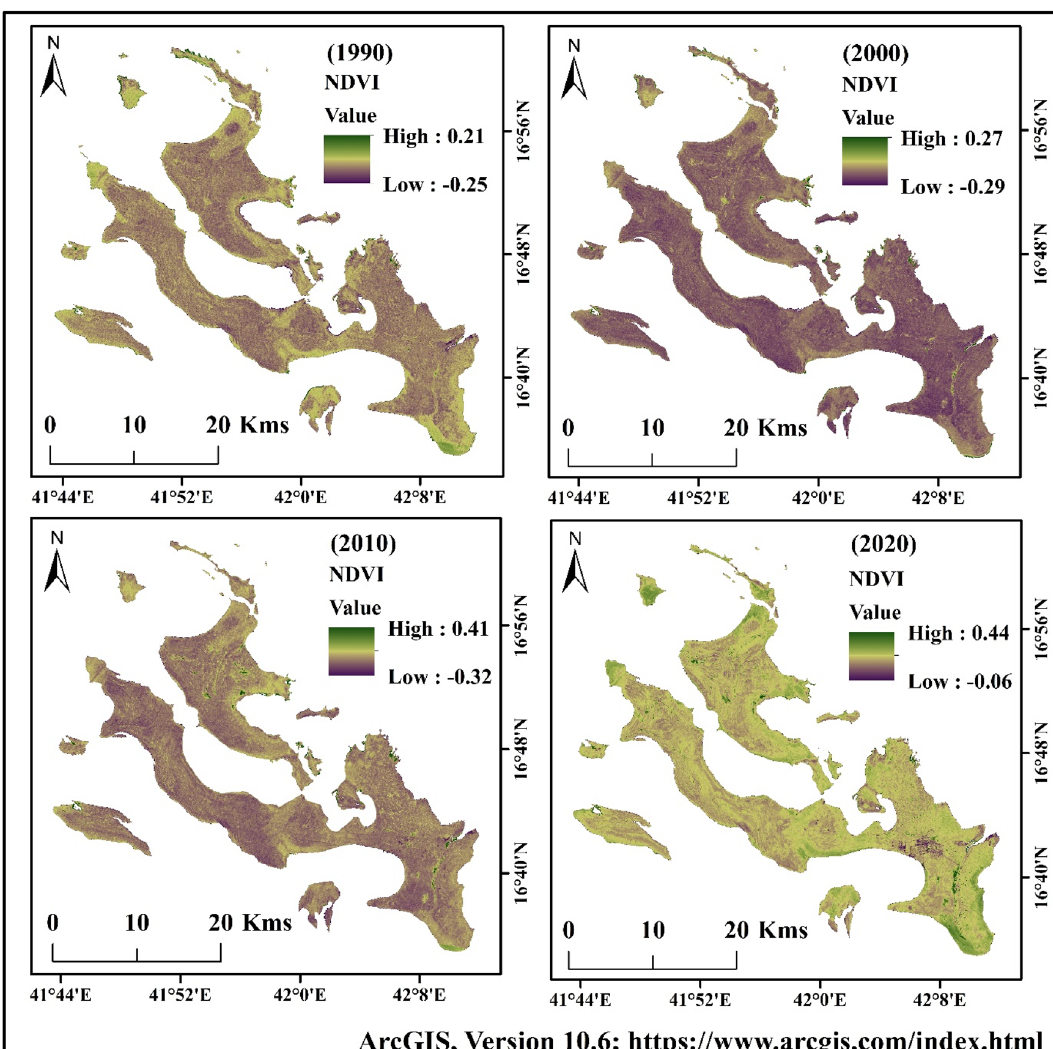
Figure 7. Normalized Different Vegetation Index (NDVI) maps of Farasan Island for 1990, 2000, 2010, and 2020 31,64 . The satellite data was downloaded from USGS earth explorer (https:// earth explo rer. usgs. gov/). The map was generated using ArcGIS software, version 10.6 (https:// suppo rt. esri. com/ zh- cn/ produ cts/ deskt op/ arcgis- deskt op/ arcmap/ 10-6-1).